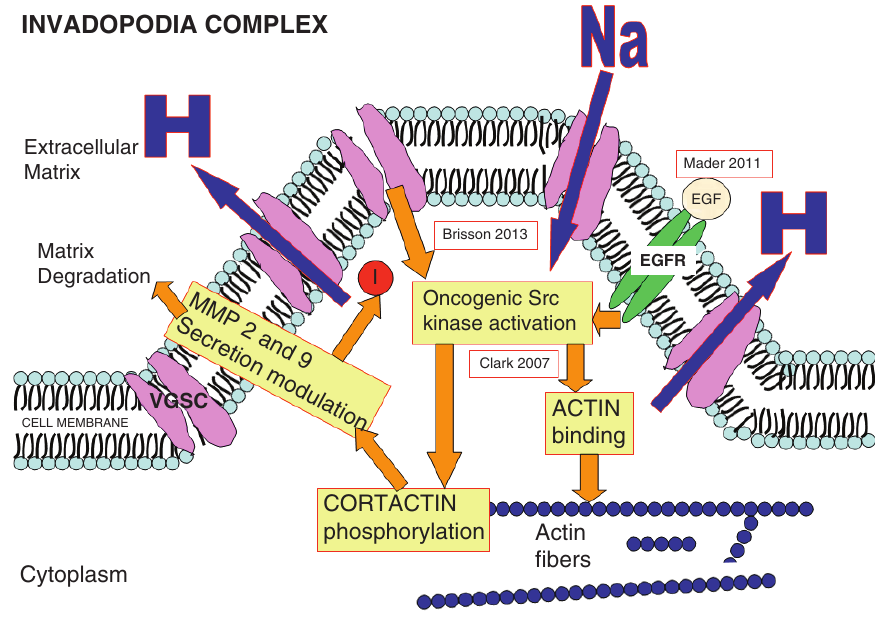
Figure 5. VGSCs. The second mechanism of action is through activation of Src which increases MMP-2 and MMP-9 secretion and activity through phosphorylation of Cortactin. It is postulated that there is a feedback loop starting with MMPs products which induces the development of new invadopodia (Red circle around I). (This figure has been constructed based on references Gillet 2009 40 , Brisson 2013 133 , Clark 2007 42 and Mader 2011 41 ).